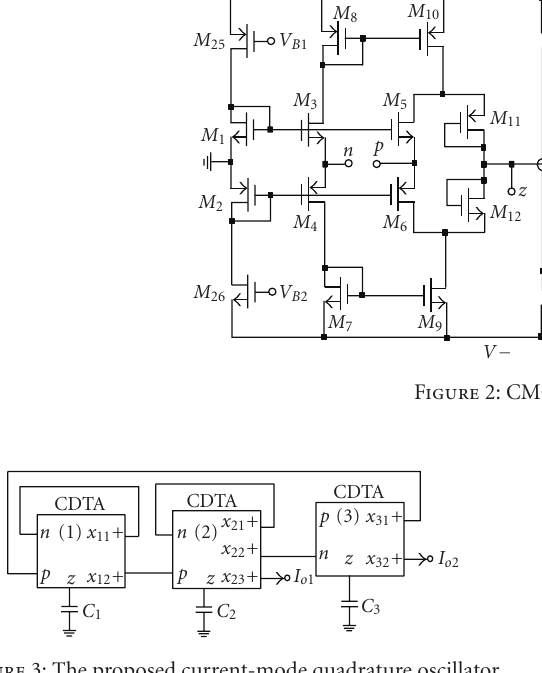
Figure 3: The proposed current-mode quadrature oscillator.